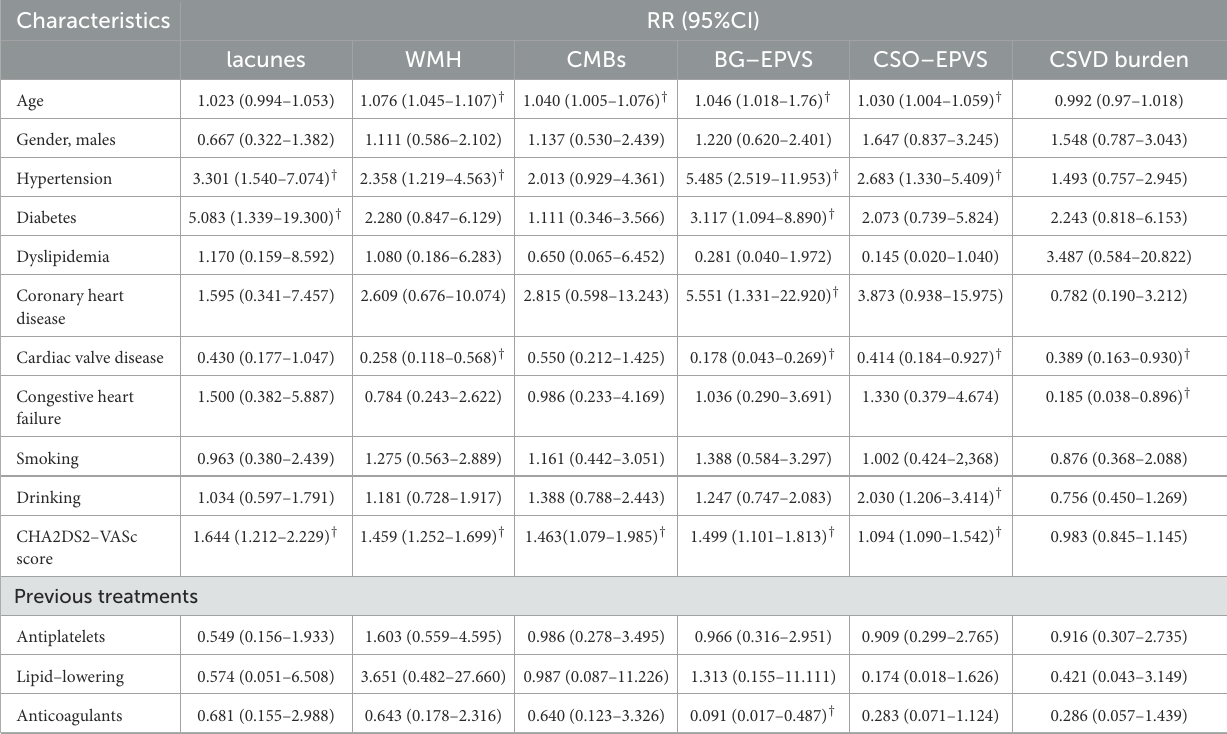
TABLE 2 Univariate analysis for clinical characteristics associated with MRI markers of CSVD.